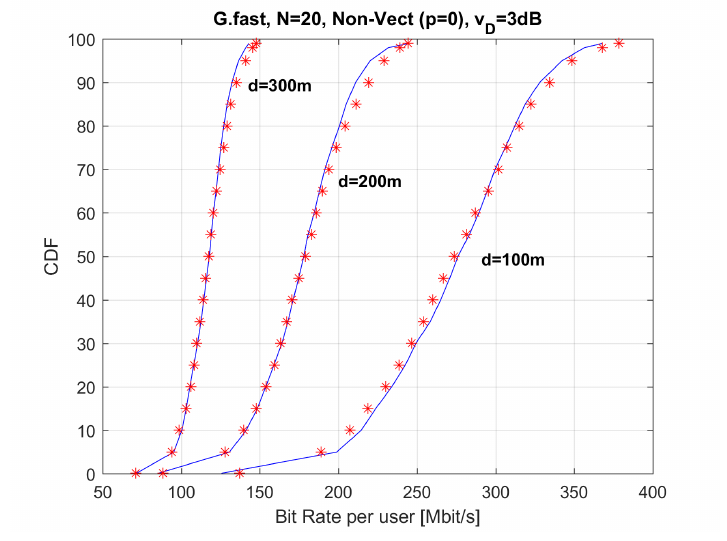
Figure 4. CDFs of the bit rate per user in the non-vectoring case for G.fast: N = 20. Exact (solid) and Gaussian approximation (asterisks) results are shown.